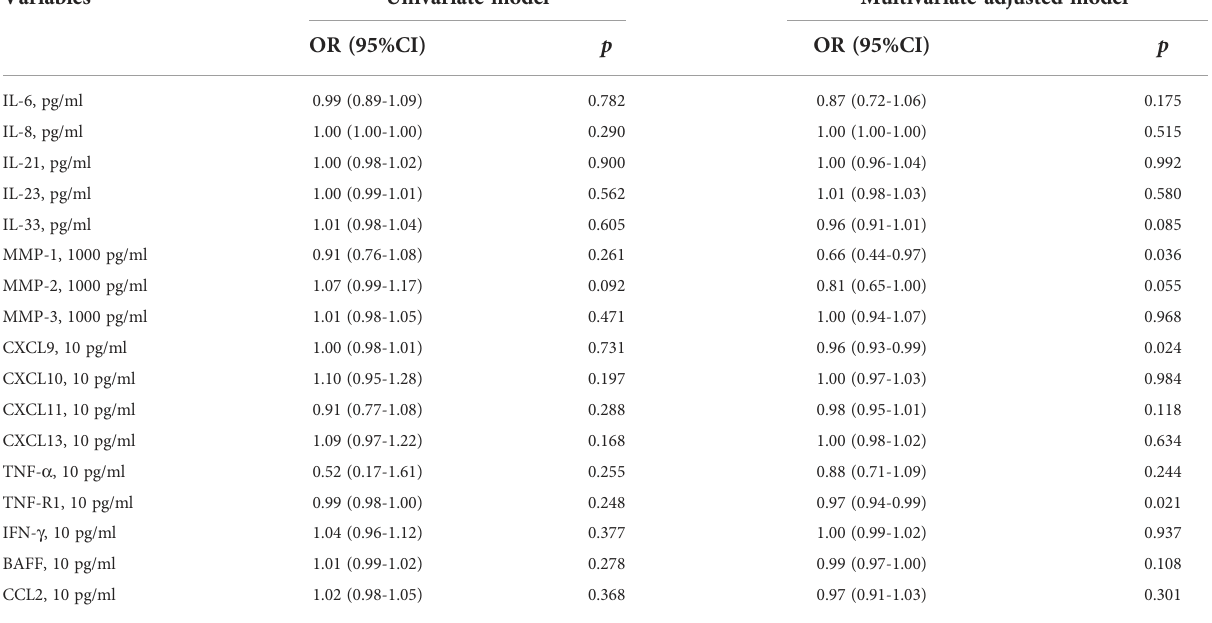
TABLE 3 Association between cytokines and HBsAg loss.